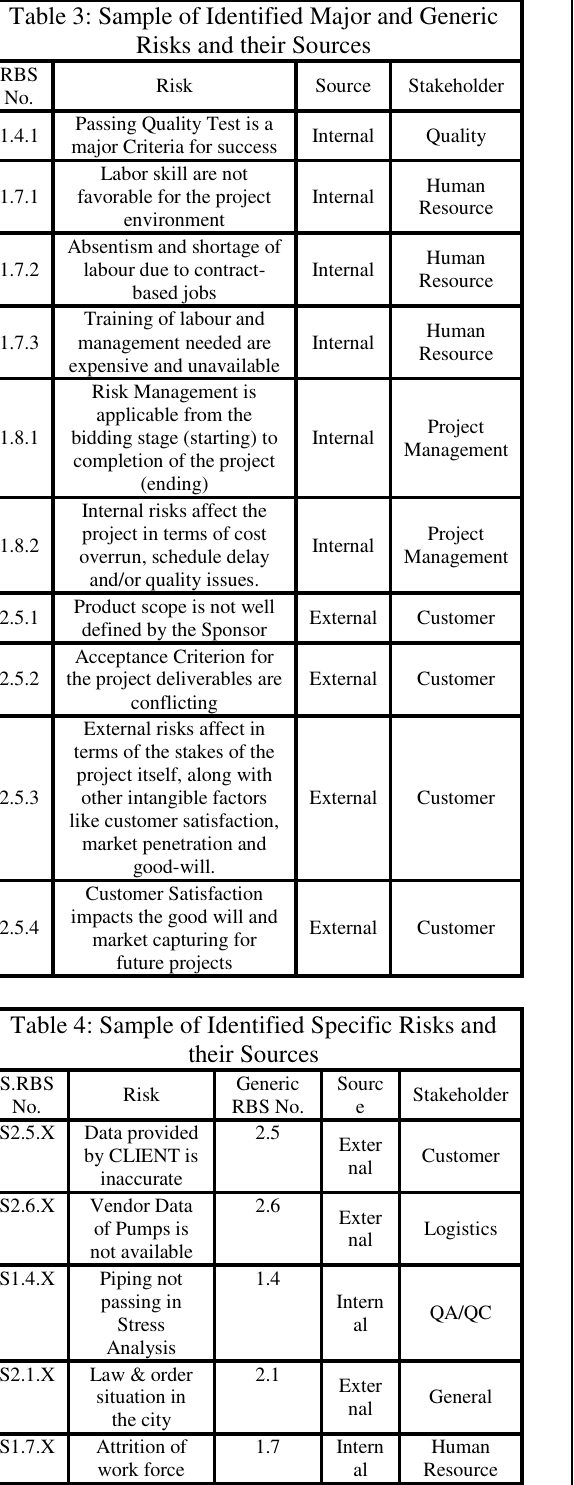
Table 5: Magnitude of Impact